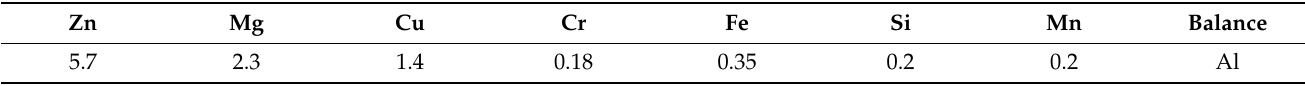
Table 1. Chemical composition of the used aluminum metal matrix alloy, AA7075 (wt%).